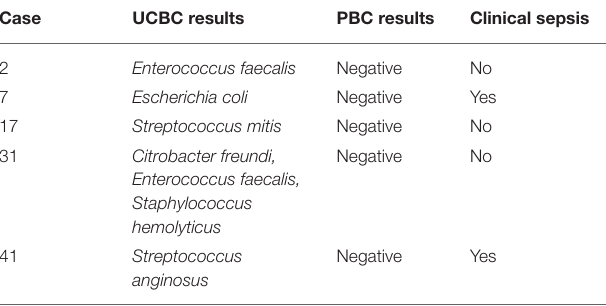
TABLE 2 | Positive umbilical cord blood culture